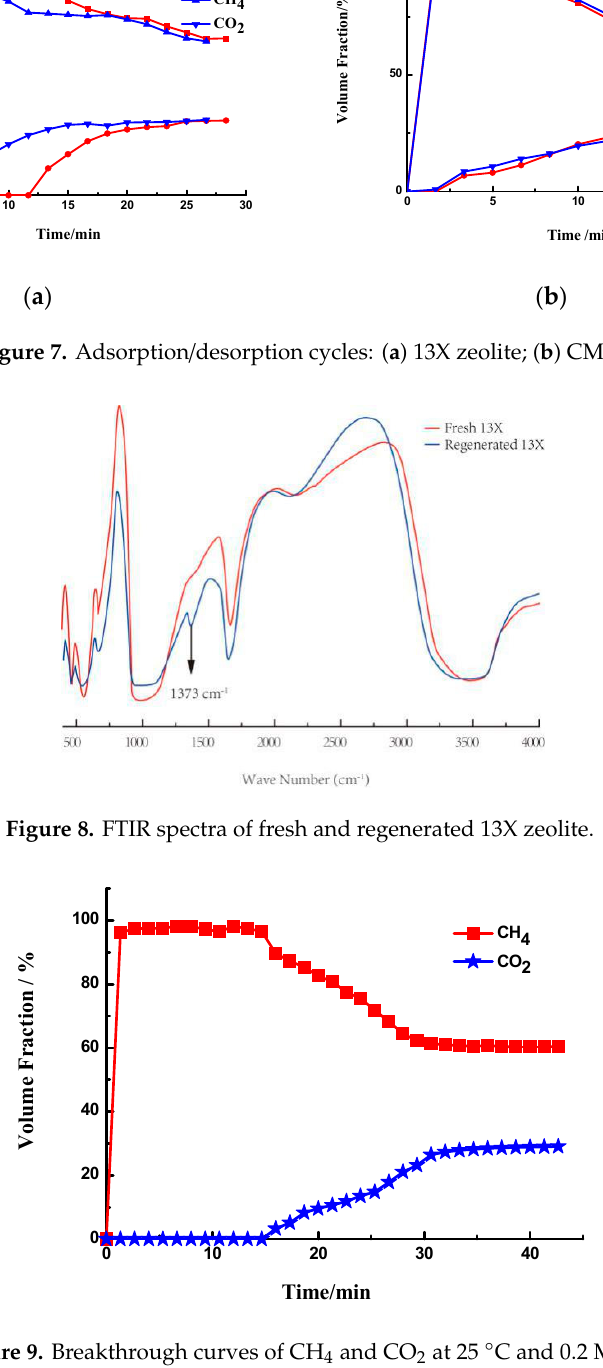
Figure 9. Breakthrough curves of CH 4 and CO 2 at 25 °C and 0.2 MPa .